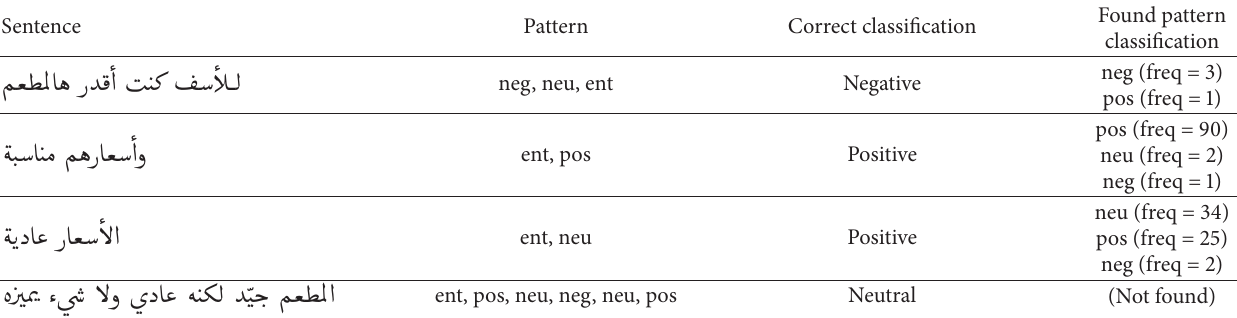
Table 1: Sample output of the pattern matching